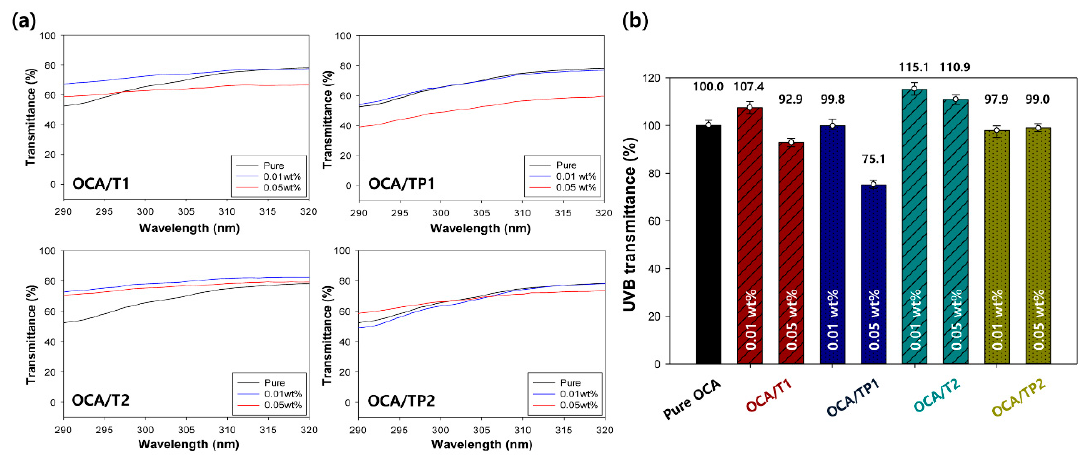
Figure 7. ( a ) UV–visible spectra and ( b ) average relative transmittances of the pure OCA and the nanoparticle-embedded OCA films in the region of UVB (290–320 nm).